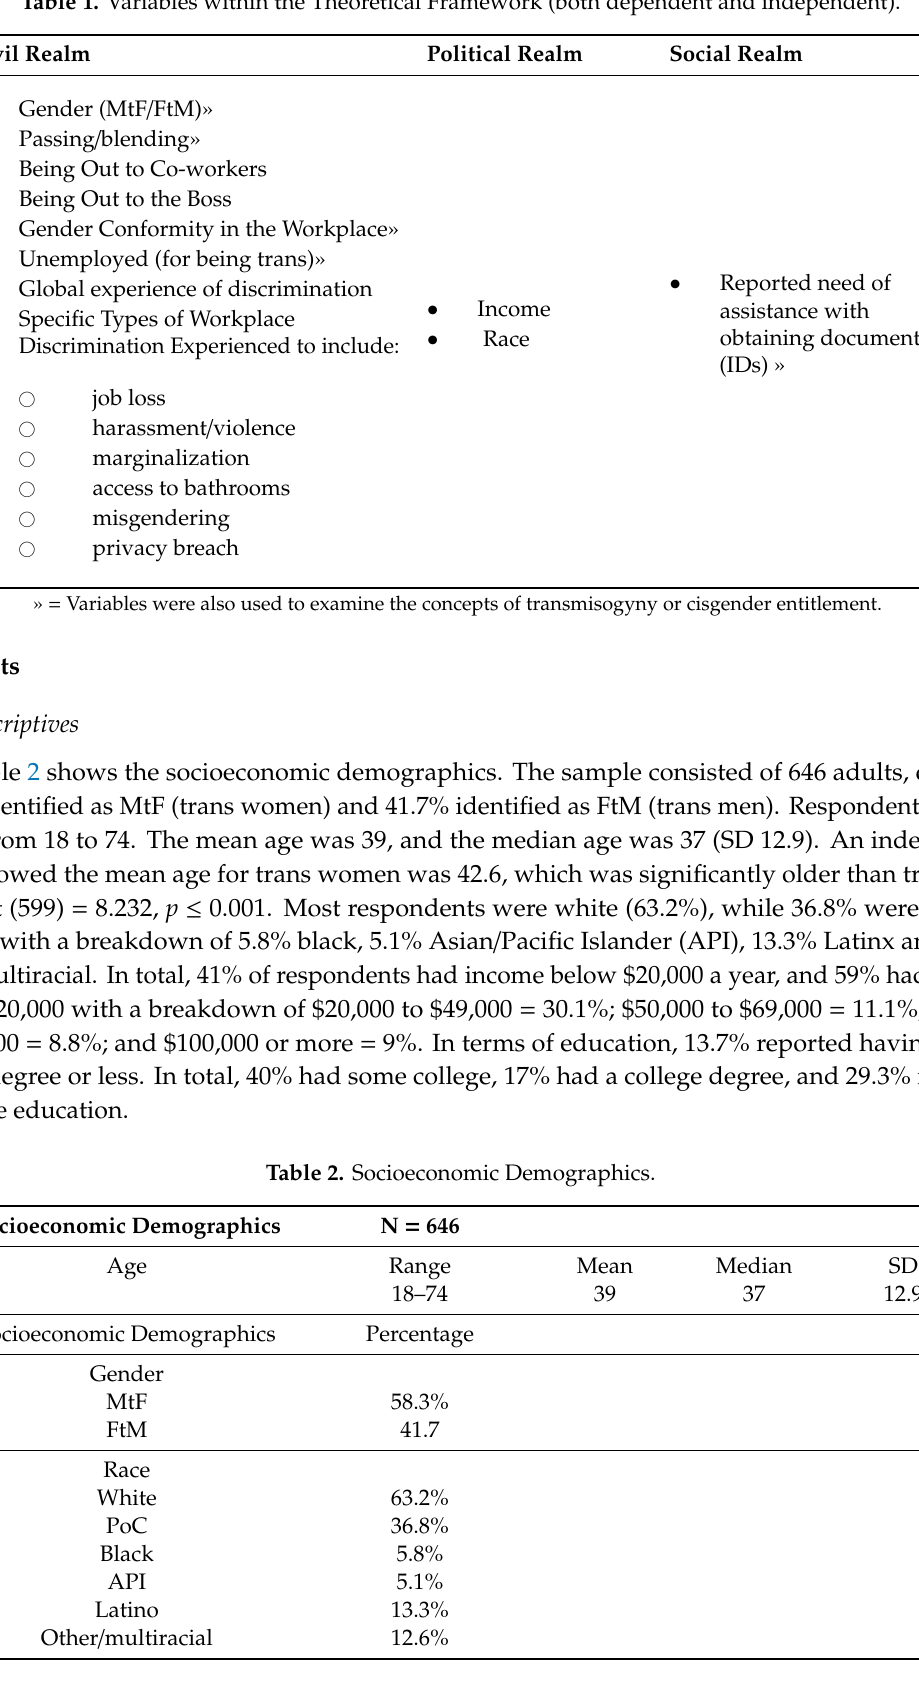
Table 1. Variables within the Theoretical Framework (both dependent and independent).